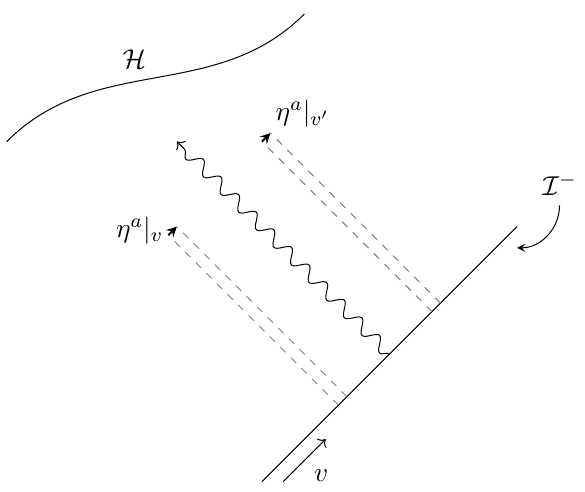
Figure 1 . A gravitational wave travels towards a (dynamical) black hole horizon H . The passing of the wave changes the geodesic deviation (cid:17) a of a (speci(cid:12)c) pair of ingoing null geodesics. This geodesic deviation is compared at two di(cid:11)erent values of v , as a way of detecting gravitational memory in the bulk of the